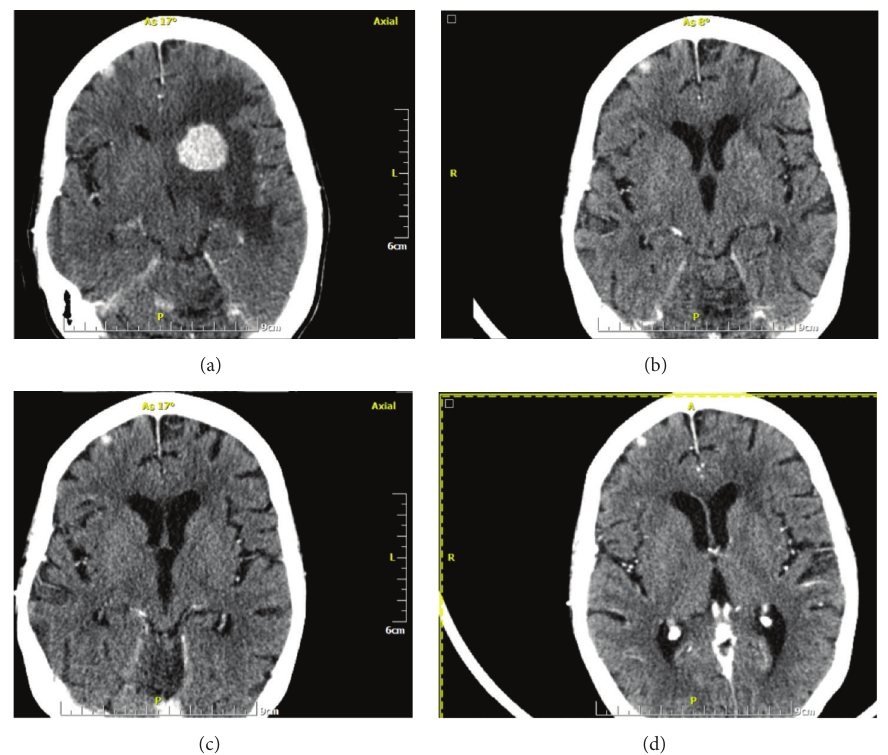
Figure 2: Brain computed tomography at baseline (a) and after 3 (b), 9 (c), and 12 (d) months of treatment with pertuzumab, trastuzumab, and taxane-based